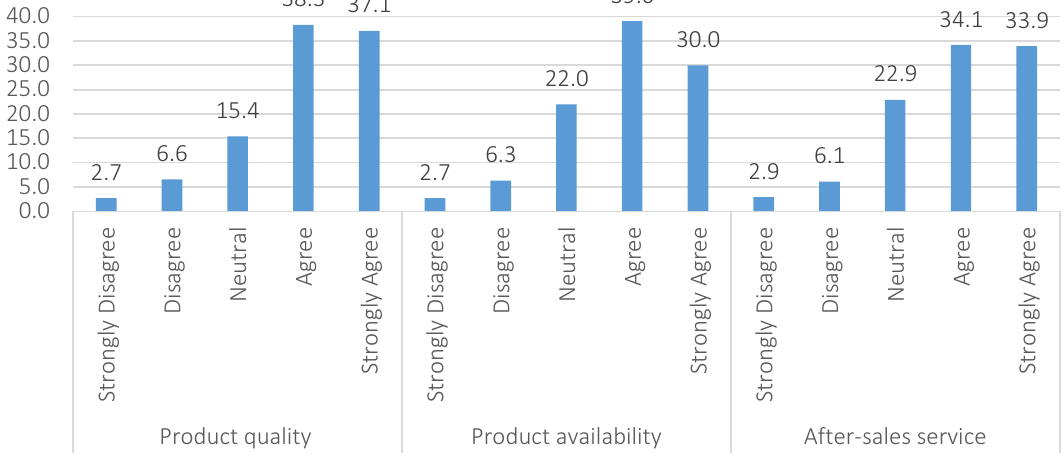
Figure 7. Background analysis based on product quality, product availability, and after-sale service Table 1. Reliability and validity test